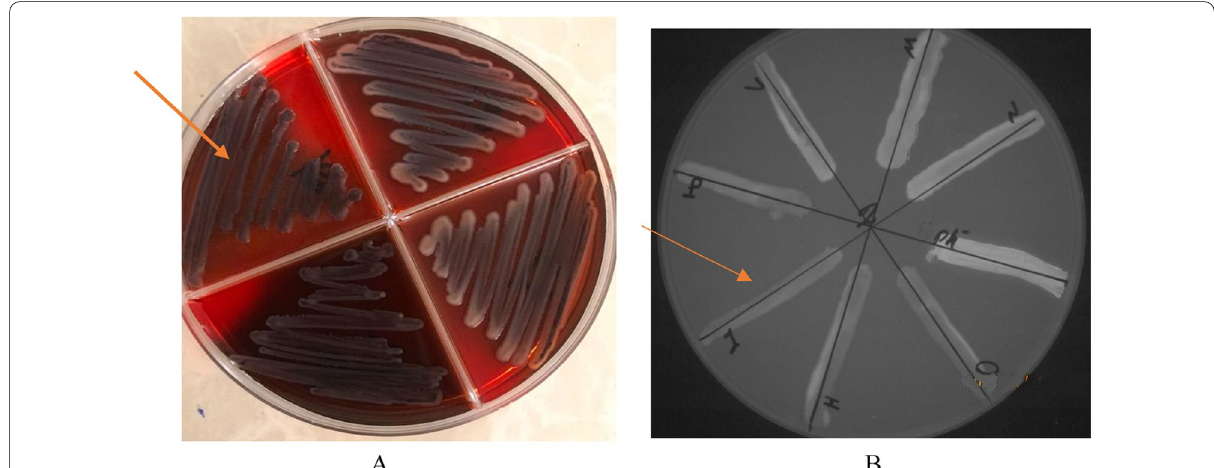
Fig. 1 Congo red agar ( A ) and Cartwheel tests ( B ) for detection of biofilm producers and efflux pump system in K. pneumoniae strains. As expected, the biofilm forming bacteria exhibited the black appearance in their colonies (Arrow). Moreover, the isolates containing efflux pump did not show fluorescent emission under UV transilluminator